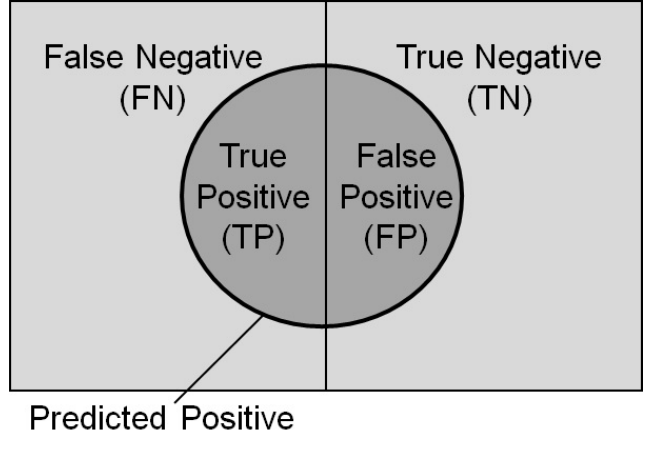
Figure 7. Confusion matrix overview. Table 4. Breakdown of detection result in each